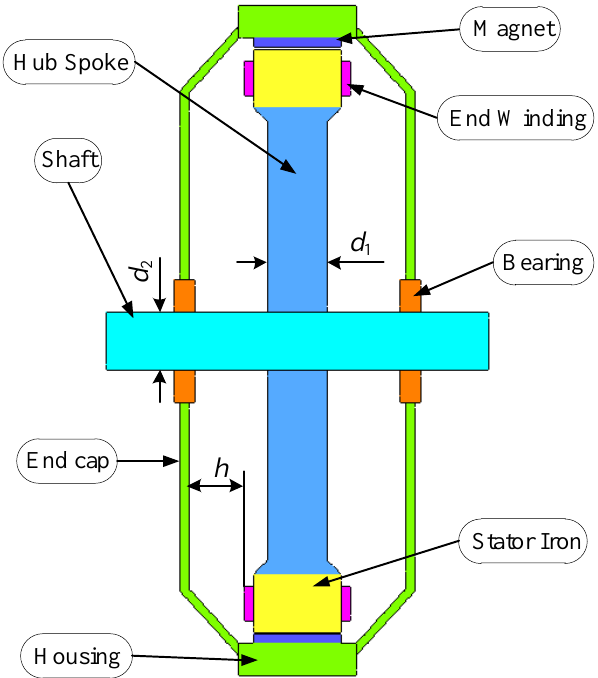
Figure 3. Structural diagram of the motor.